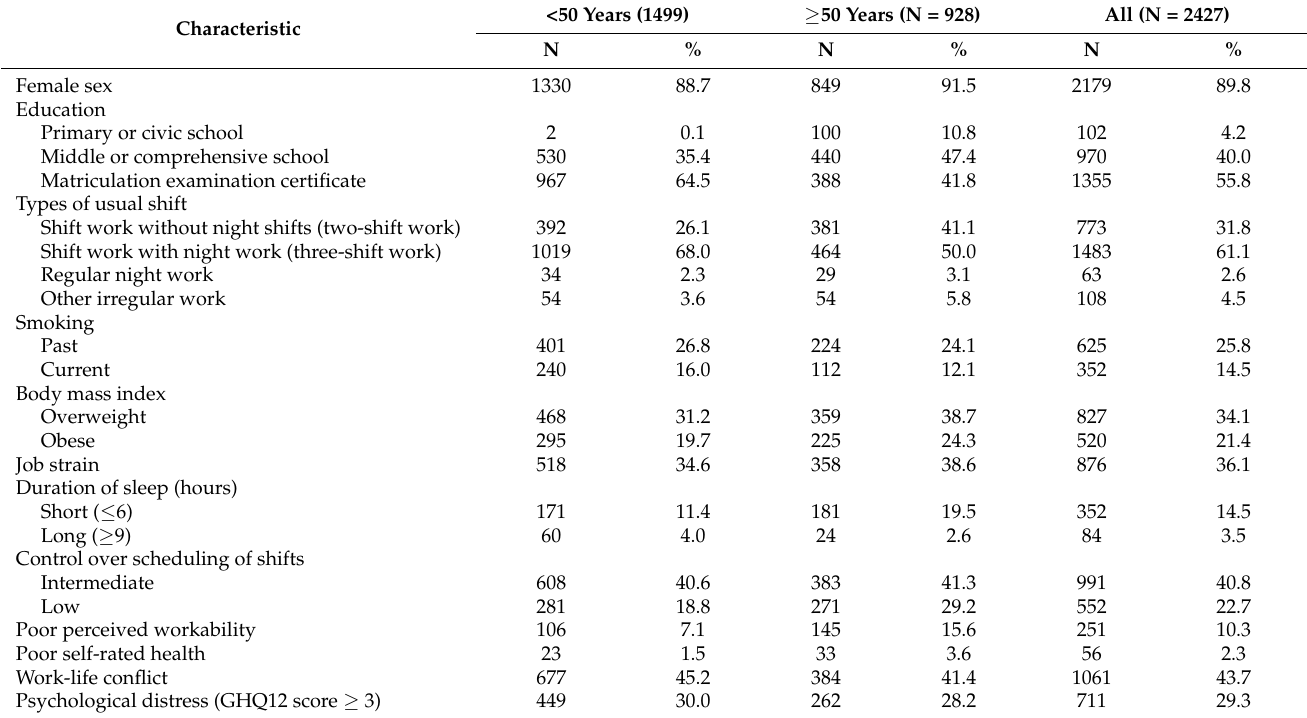
Table 1. The baseline characteristics of the study population by age